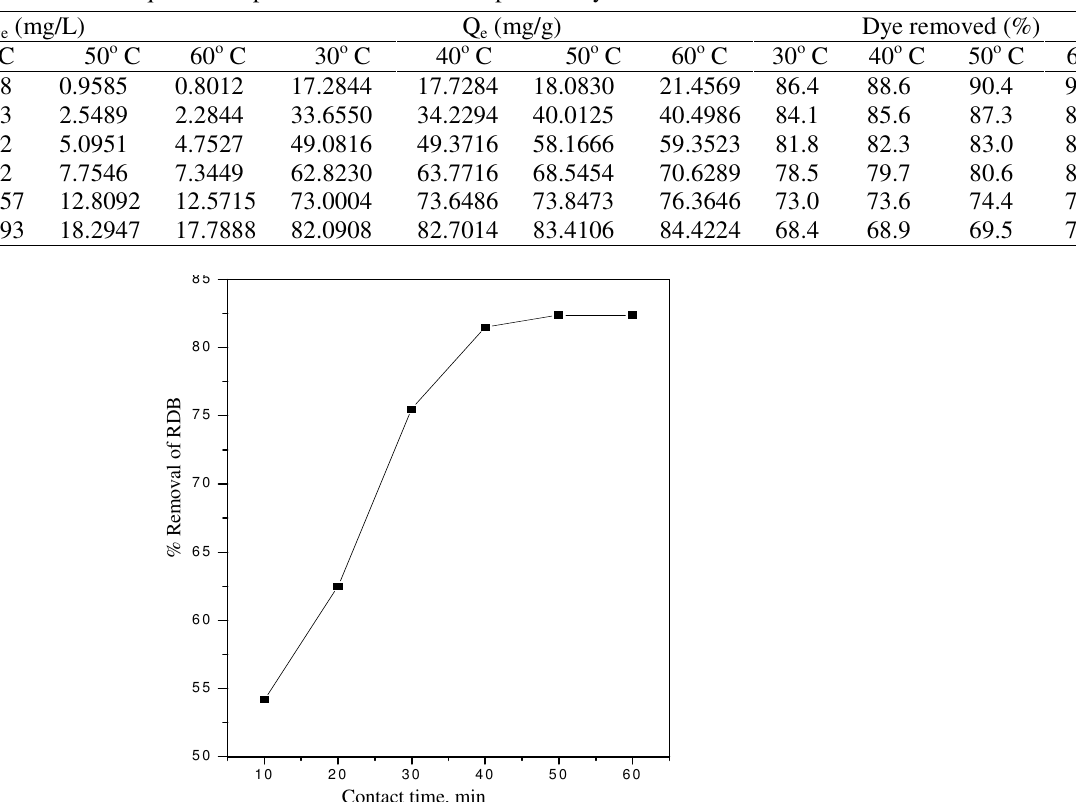
Table 2. Equilibrium parameters for the adsorption of dye onto activated Carbon.